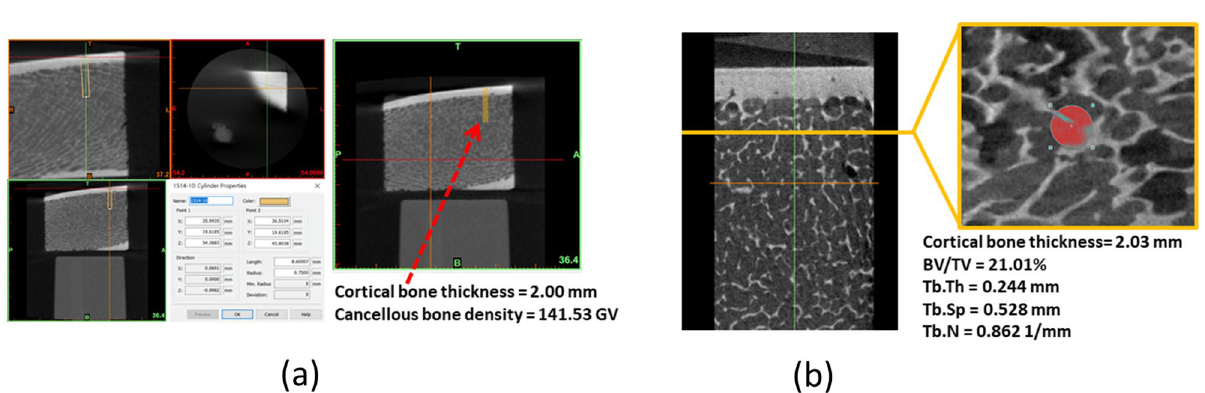
Figure 6. ( a ) Cortical bone thickness (in mm) and cancellous bone density (GV) measured from CBCT images; ( b ) cortical bone thickness (in mm) and four trabecular bone misconstruction parameters [BV/TV (%), Tb.Th. (mm), Tb.Sp. (mm), and Tb.N. (1/mm) measured from micro-CT